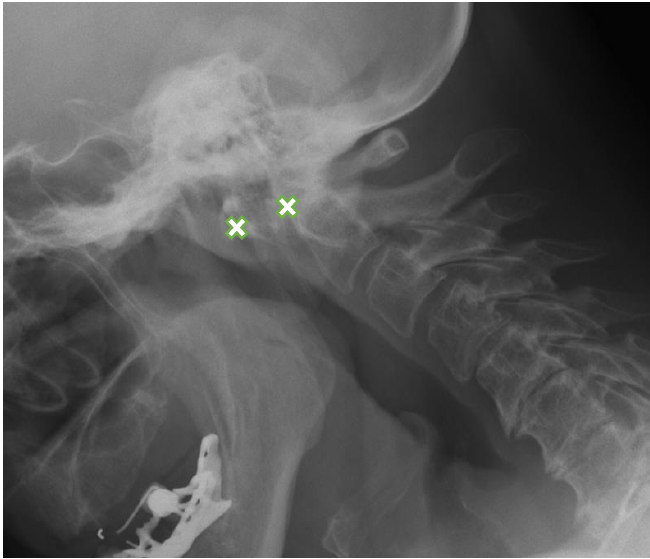
Figure 1. Lateral flexion view radiograph in a 63-year-old female with rheumatoid arthritis shows anterior AAS-8.8 mm (between crosses). AAS: atlanto-axial subluxation .